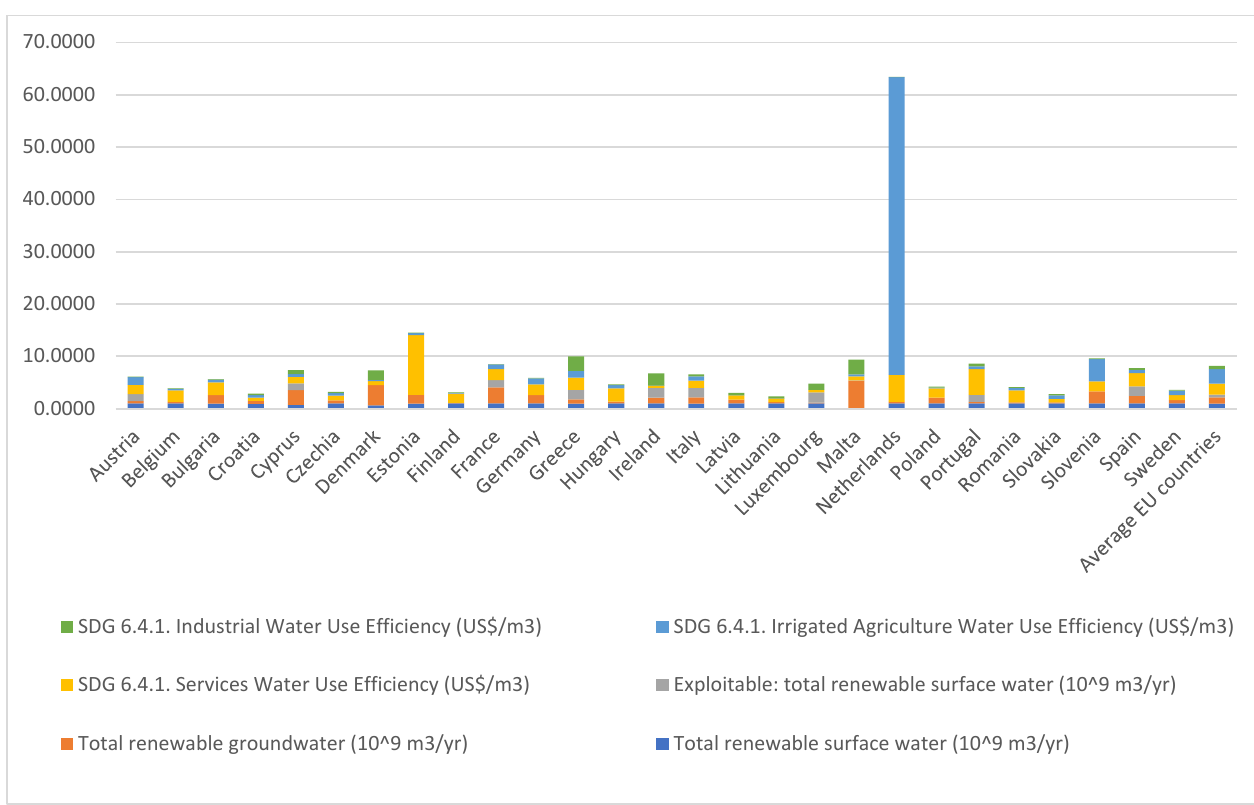
Figure 5. Economic inequalities indicators of EU countries.